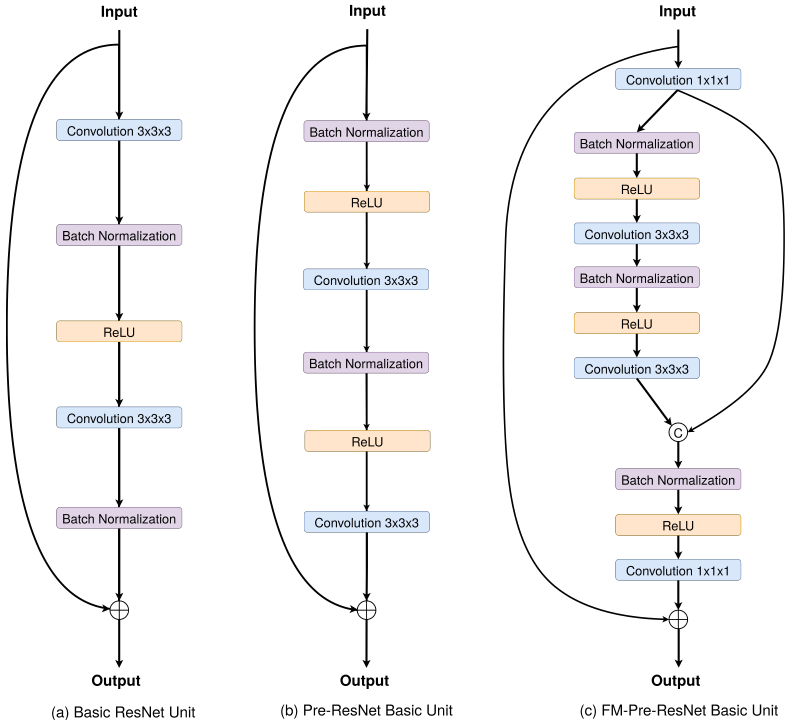
Figure 2. An illustration of different connectivity types of residual units. ( a ) original residual unit; ( b ) pre-ResNet unit; ( c ) proposed FM-Pre-ResNet